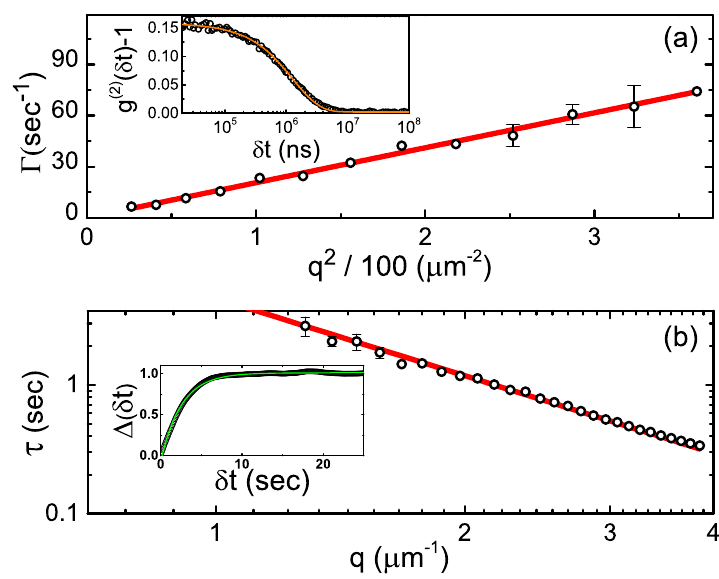
Figure 2. ( a ) Particle sizing by DLS (dynamic light scattering). The experimental decay rate Γ (scatter) of the DLS intensity autocorrelation function g ( 2 ) ( δ t ) is shown to scale linearly with q 2 , indicative of a low particle polydispersity. The red line is the theoretical fit, from which the particle diffusion constant is extracted. A representative autocorrelation function (obtained at θ = 55 ◦ ) is shown in the inset (scatter); note the perfect match by the theoretical fit (Equation (1), solid curve). ( b ) Particle sizing by ConDDM (confocal differential dynamic microscopy). The correlations between the subsequent images decay over time τ ( q ) , which for the dilute samples is linear in q 2 ; note the double-logarithmic scale. The experimental data (scatter) are fitted by the theory ( red line), allowing the diffusion coefficient to be extracted. The extracted value is in a perfect agreement with the DLS, indicating a significant swelling of the particles in the solvent. The inset shows a typical variation of ∆ ( δ t ) (in arbitrary units), which stems from the decay of the correlations between the images. Note the perfect agreement between the experiment (scatter) and the theoretical fit (solid green